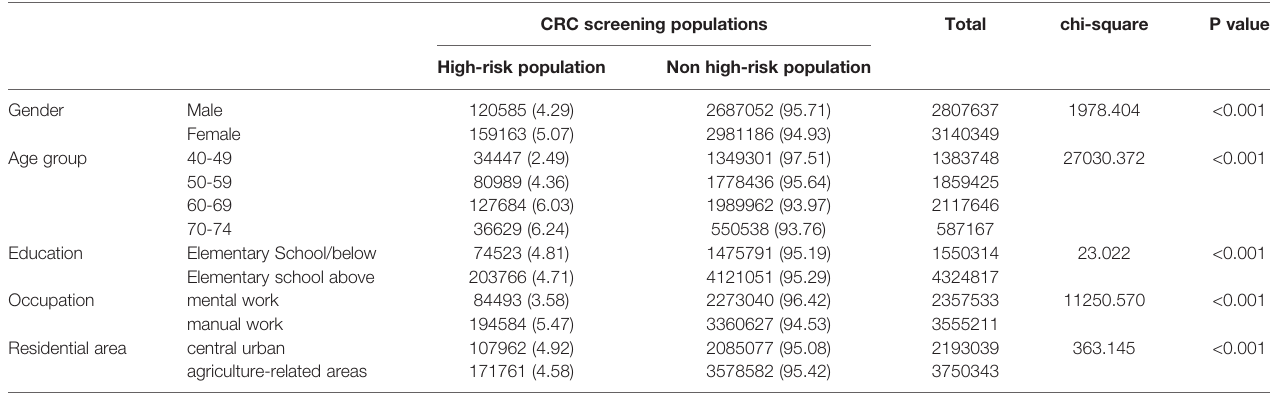
TABLE 4-2 | Comparison of colonoscopy and non colonoscopy in high-risk population (2012-2020), (n, %).